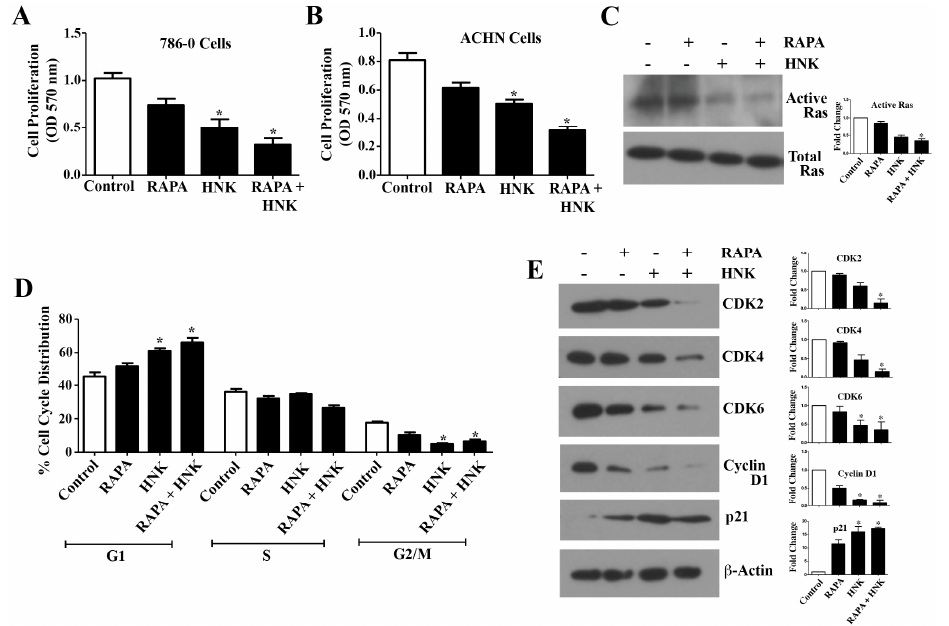
Figure 2. Combination treatment with Rapamycin (RAPA) and Honokiol (HNK) e ff ectively inhibits renal cancer cell proliferation and induces cell cycle arrest. ( A ) 786-0 and ( B ), ACHN cells were treated with RAPA (15 µ M) and Honokiol (40 µ M) either alone or in combination for 48 h and cell proliferation was measured by MTT assay. ( C ) 786-0 cells were treated with RAPA (15 µ M) and Honokiol (40 µ M) either alone or in combination for 1 h. Following treatment, cell lysates were used to assess Ras activation statuses using GTP-bound Ras pull down assay kit, as described in “Materials and Methods” section. ( D ) 786-0 cells were treated with RAPA (15 µ M) and Honokiol (40 µ M) either alone or in combination for 24 h. Following treatment, cells were stained with propidium iodide and the percentage of cells in di ff erent phases of the cell cycle was determined by flow cytometry and the quantifications are presented. ( E ) Following treatment as described in D, 786-0 cells were lysed and the expression of CDK2, CDK4, CDK6, Cyclin D1, p21 and β -actin were determined by Western blot analysis. A, B, and D, the columns represent the mean ± S.D. of triplicate readings of two di ff erent samples. * p < 0.05 compared with respective controls. ( C , E ) results shown are representative of three independent experiments; and the bar graphs presented next to the Western blots correspond to the fold changes in the expression of the indicated proteins, which were calculated by densitometric analysis of the intensities of protein bands normalized to those of β -actin. The control values were considered as 1 fold. The columns represent the mean ± S.D. of the readings of two di ff erent samples. * p < 0.05 compared with respective controls.